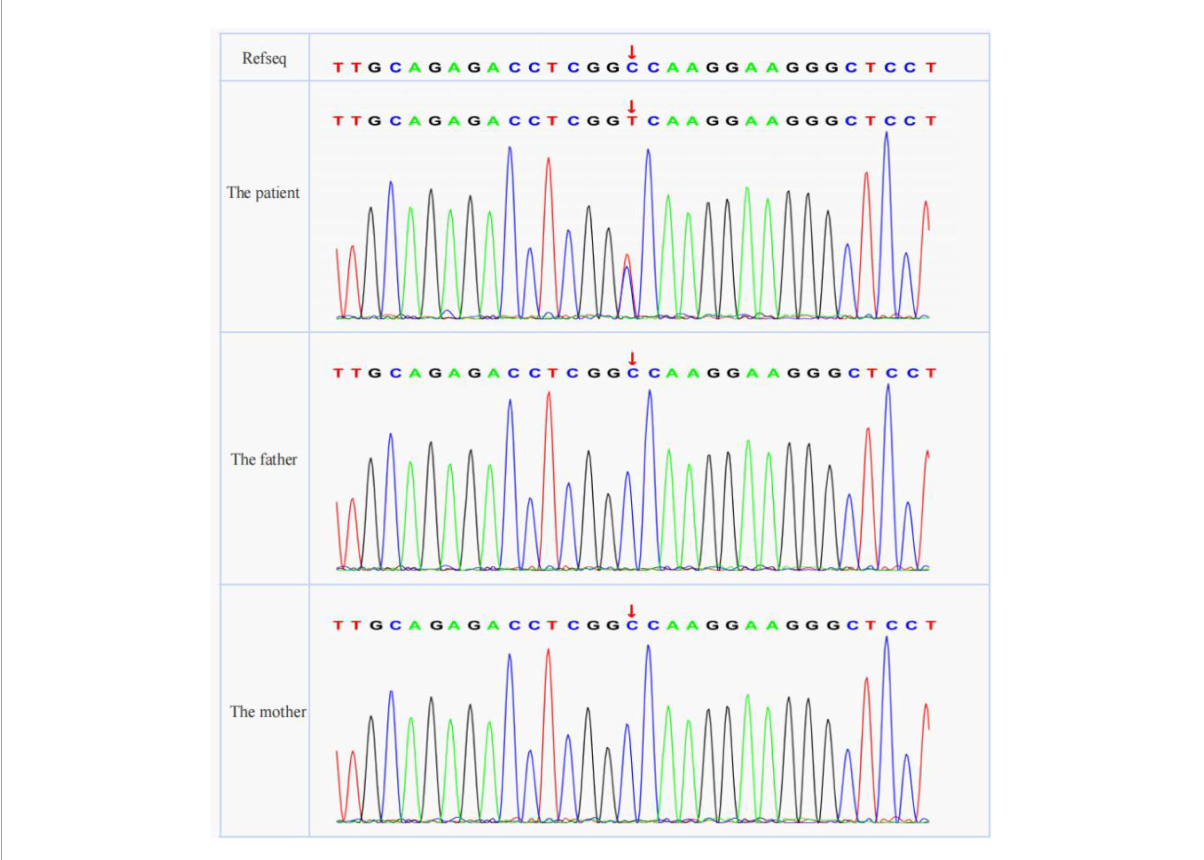
FIGURE2 The results of Sanger sequencing ( ACTN4 variant was marked with red arrows).